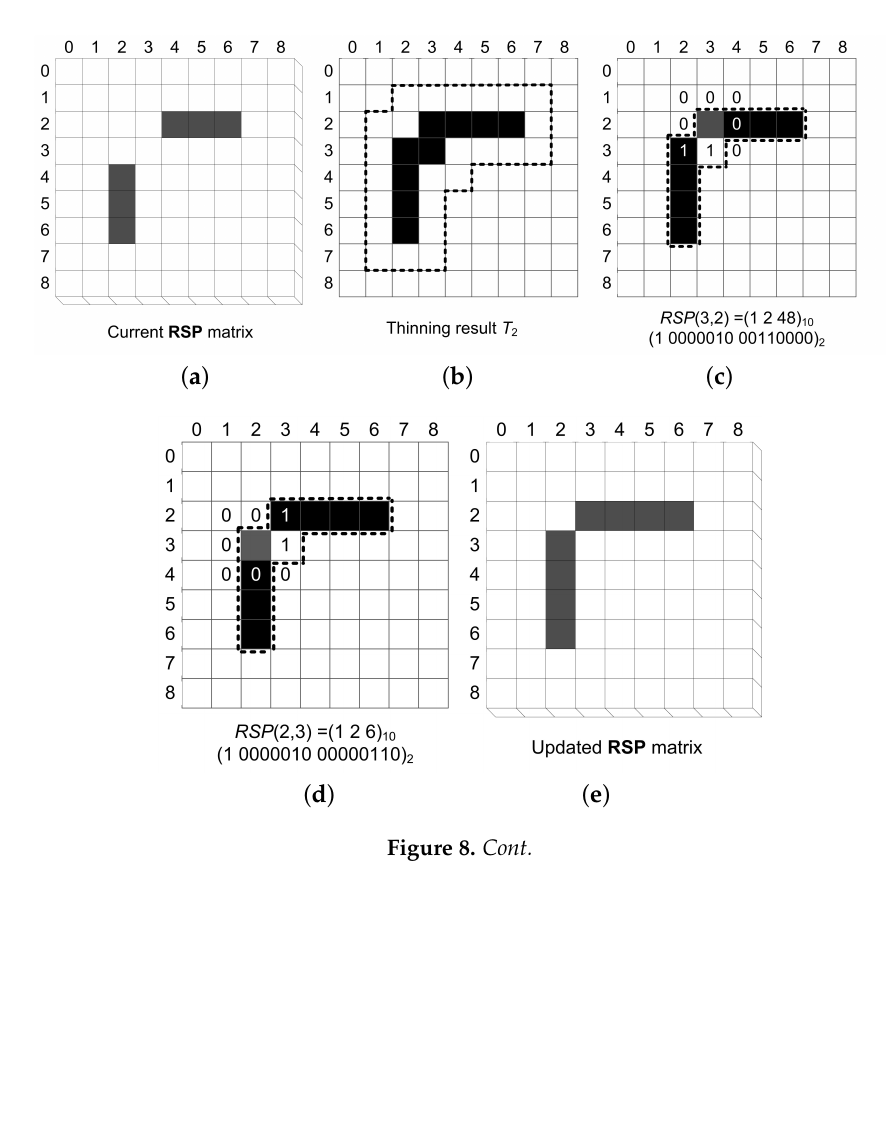
Figure 7. Illustrations of RSP updating from T 1 to T 2 . ( a ) Null RSP matrix initially. That is, the RSP information is set to be (0 0 0) 10 in decimal or (0 000000 00000000) 2 in binary. ( b ) Thinning result T 1 , where the original pattern is regarded as T 0 and confined by a dotted line for reference. ( b – h ) show the updated RSP information for each 1-pixel P satisfying C ( P ) = 0 in T 2 , where the reconstructable information R ( P ) is numbered. ( i ) The updated RSP pixel is denoted with a gray